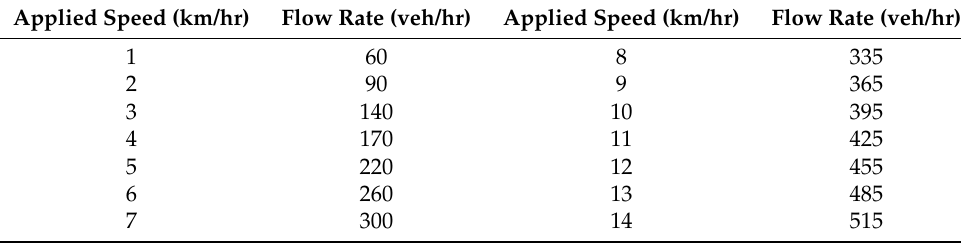
Figure 6. Speed flow diagram. Table 4. Applied speed and corresponding flow